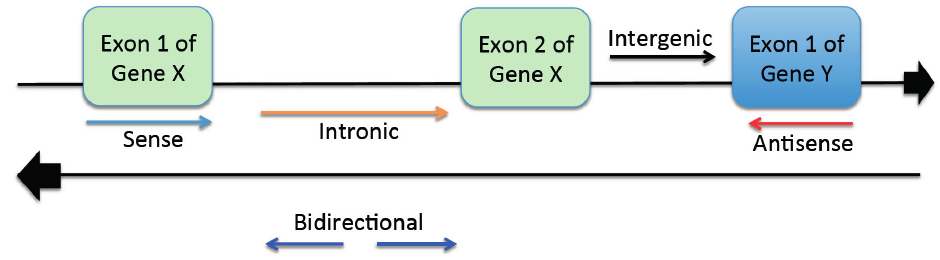
Figure 1. Schematic diagram of representative classes of lncRNAs. Long non-coding RNAs are divided into five subgroups. The groups are based on the genomic locations where the lncRNAs are transcribed from the non-coding